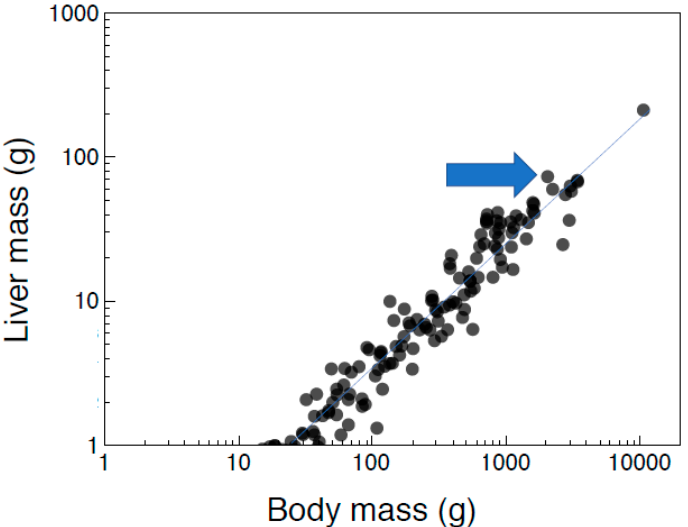
Figure 1. Liver mass (g) in 178 species of birds in relation to body mass (g) with the line being the allometric relationship and the observation at the blue arrow being the common eider Somateria mollissima . The line is the log-log regression line.